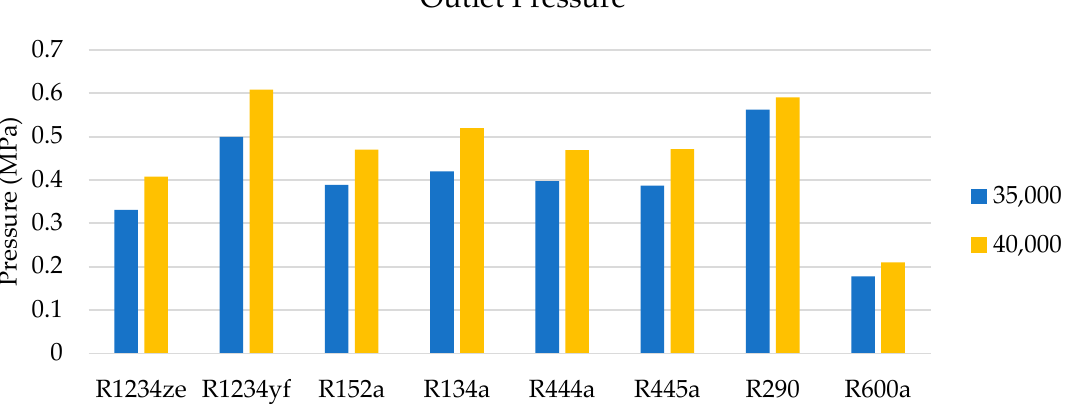
Figure 14. Comparison of Outlet Pressure Achieved for each Working Fluid at an RPM of 35,000 and 40,000.